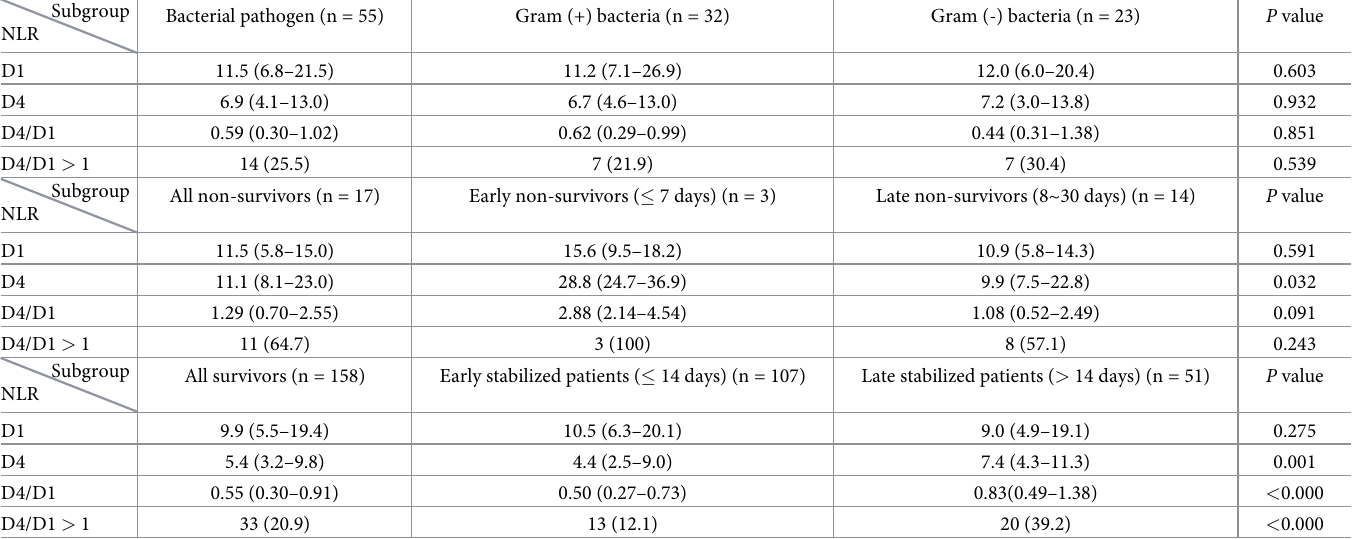
Table 3. NLR values in several